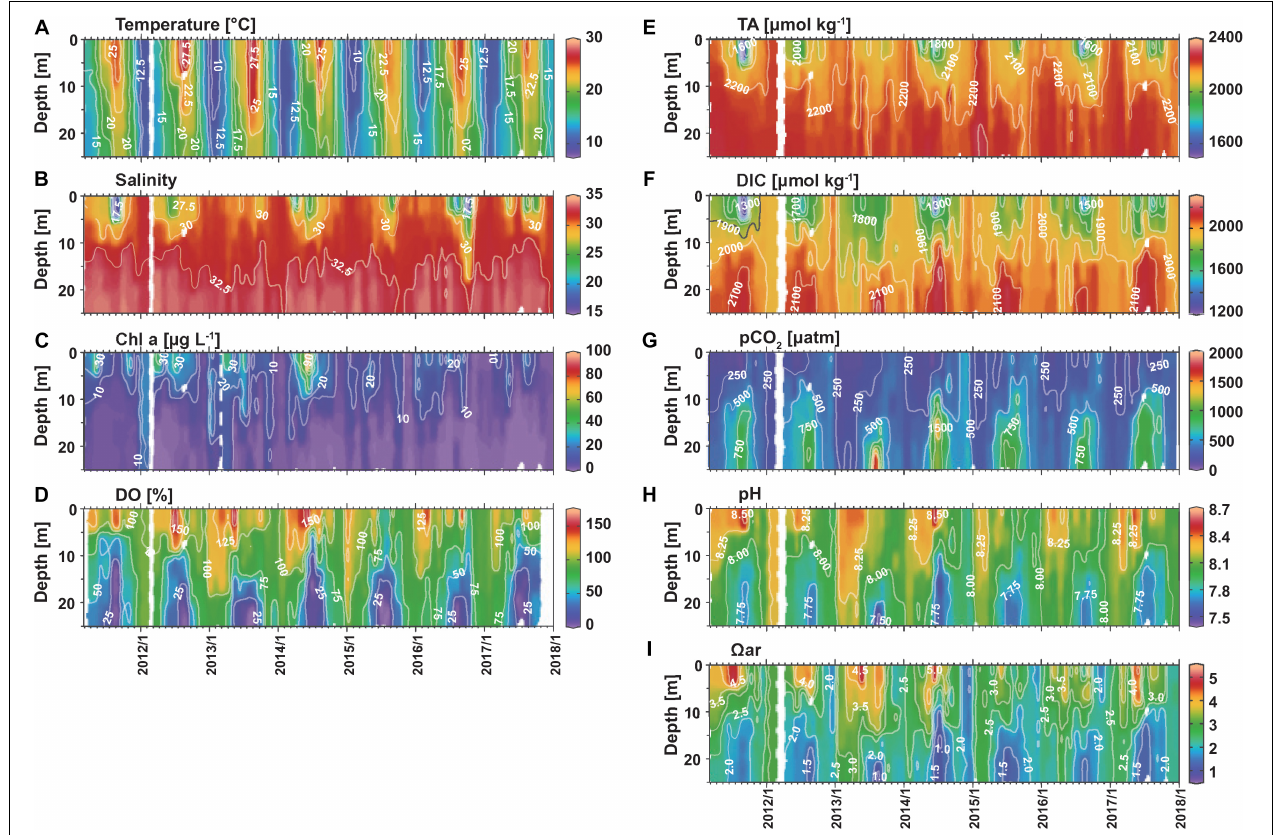
FIGURE 3 | Time series of (A) T, (B) S, (C) Chl a , (D) DO%, (E) TA, (F) DIC, (G) pCO 2 , (H) pH, and (I) (cid:127) ar at station F3.